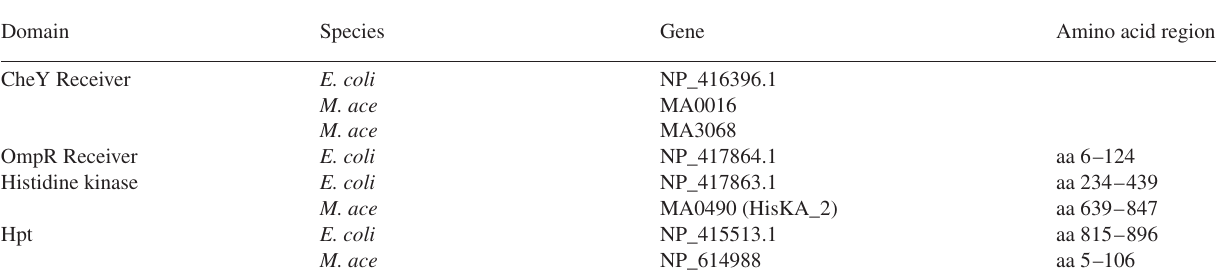
Table A1 shows the two-component protein domains used for BLASTP. Figures A1 to A5 show maximum likelihood phylogenetic analyses. Table A2 shows closely linked genes that may be part of operons. Table A1. Two-component protein domains from M. acetovrans ( M. ace ) and Escherichia coli K12 ( E. coli ) used for BLASTP searches, showing the online accession numbers and the amino acid range that was used. Abbreviation: aa = amino